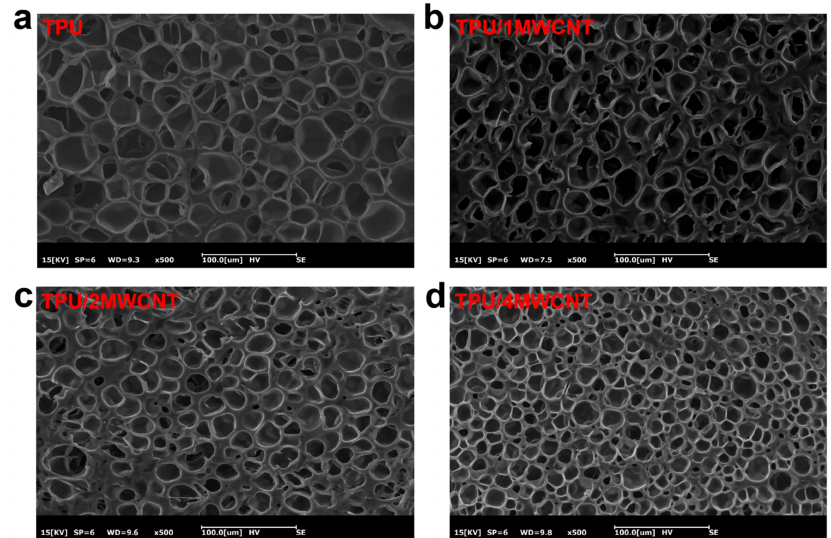
Figure 2. ( a ) Microscopic cells morphology of TPU foam; and ( b – d ) microscopic cells morphology of TPU/MWCNTs composite foam with different MWCNTs content (1, 2, 4 wt%). (Magnification: 500).